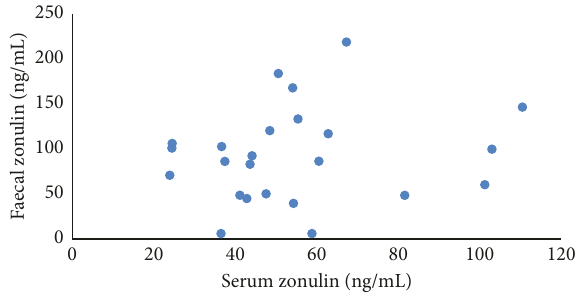
Figure 3: Correlation ( r 0 . 16 ,p 0 . 456) between serum and (cid:31) (cid:31) faecal zonulin concentrations at baseline in CU patients in re- mission ( n 24 paired samples). (cid:31)